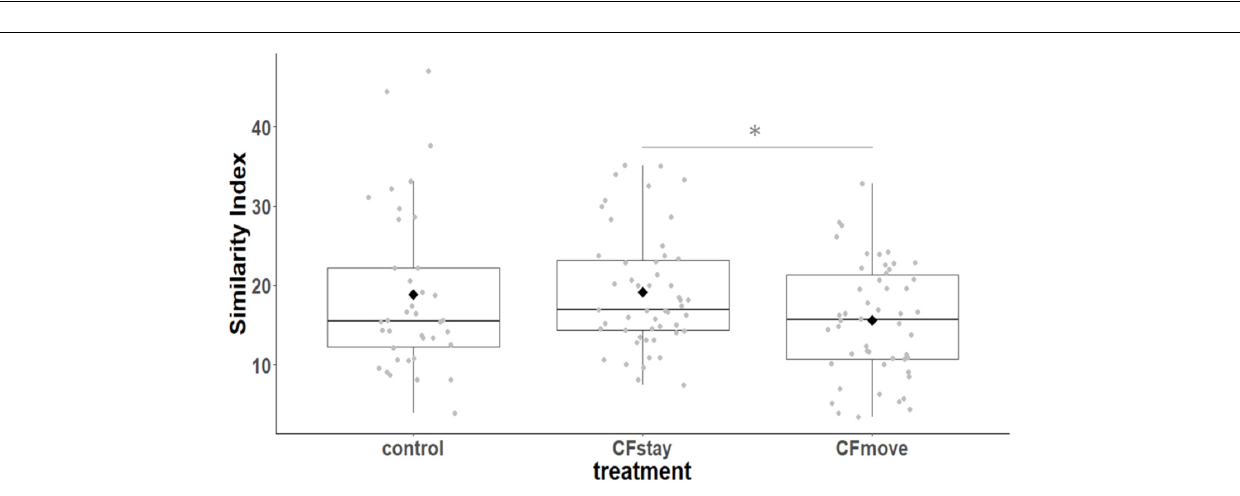
FIGURE 4 | Intra-individual cloacal microbiota similarity (Jaccard distance) between D8 and D15 according to the experimental categories. Median represented by the black line, the mean by the black dot, 25 and 75% quartiles by the lower and upper box and 90% confidence interval by the whiskers. Asterisk refers to statistical differences with p -value <